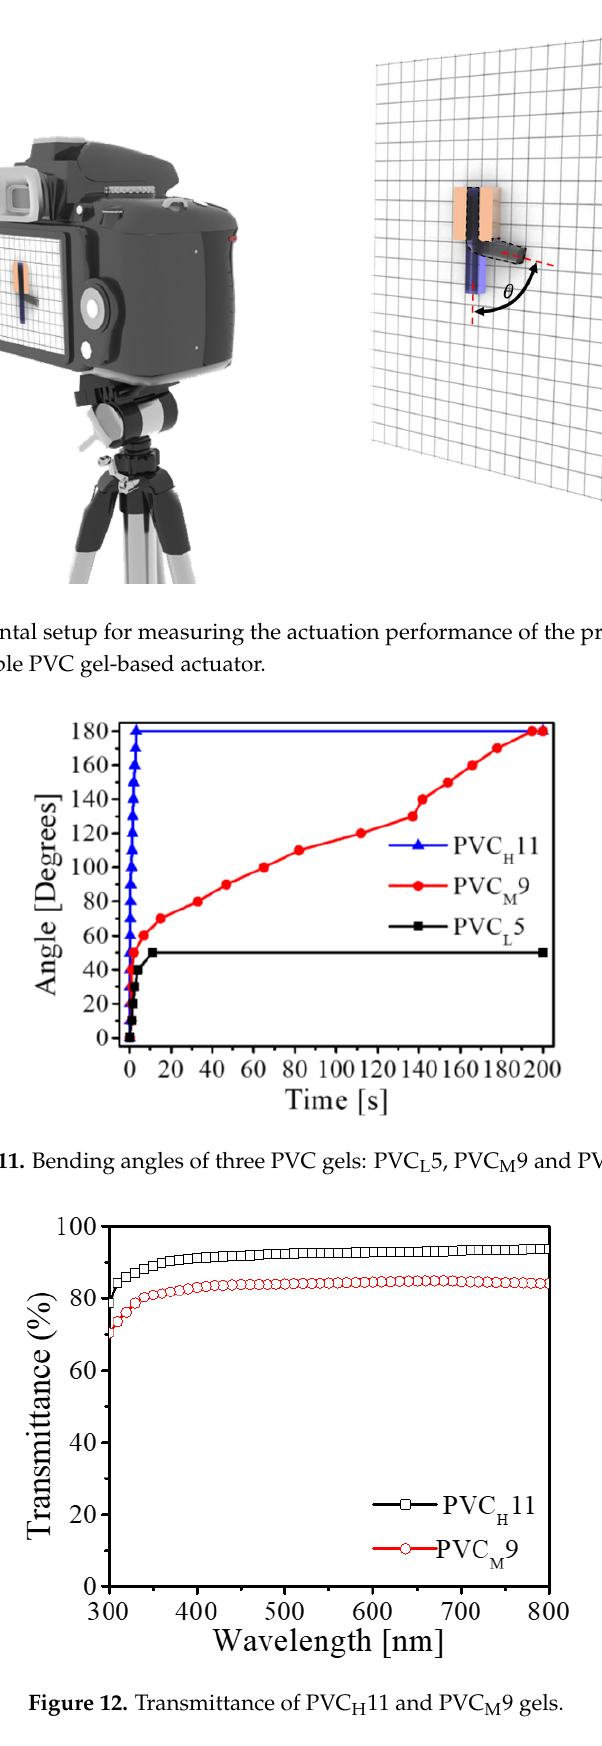
Figure 12. Transmittance of PVC H 11 and PVC M 9 gels.